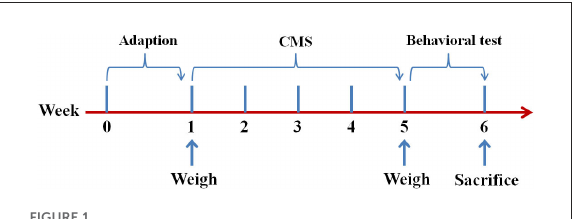
FIGURE1 Time schedule for the CMS procedure and behavior tests. CMS, chronic mild